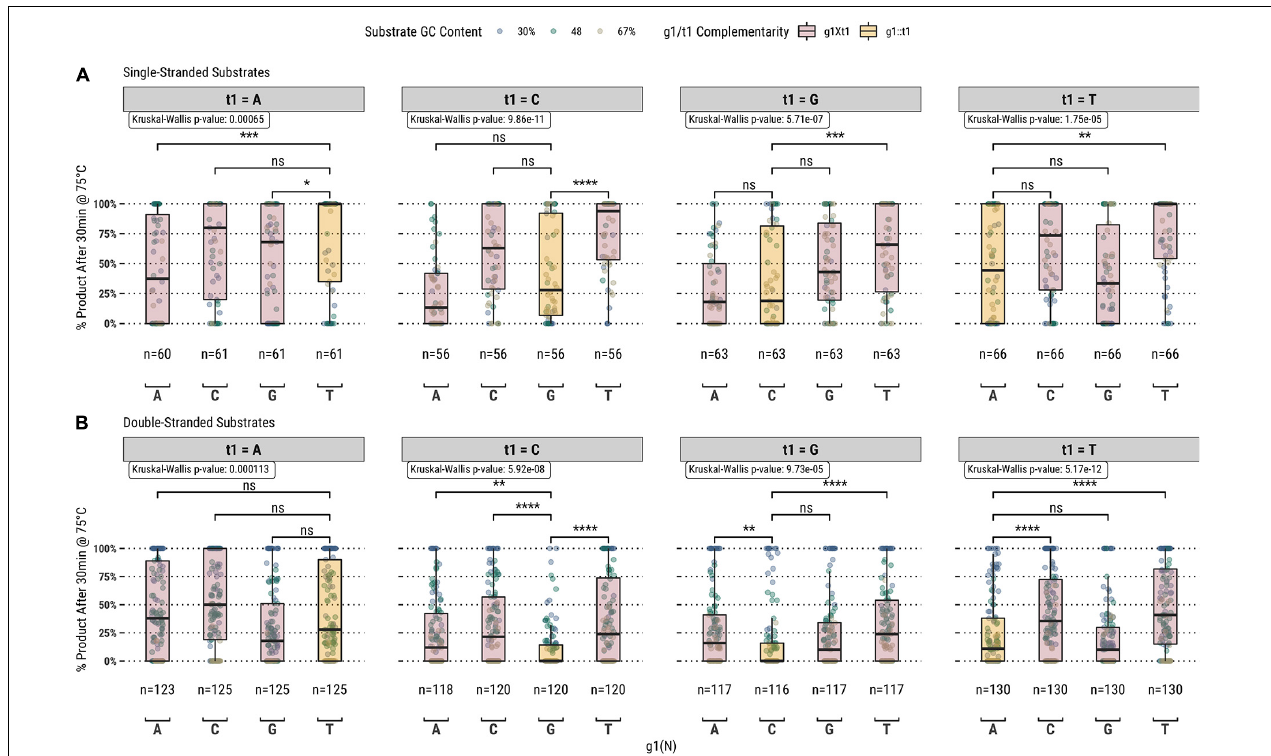
FIGURE 2 | Guided-endonuclease activity of TtAgo using fully-complementary guides, where g1 is complementary to t1 (g1:t1), and partially complementary guides, where g1 is not complementary to t1 (g1Xt1) acting on (A) single-stranded and (B) double-stranded DNA substrates. Significance levels shown only for g1:t1 to g1Xt1 comparisons. Boxplots have been annotated for statistical significance between relevant groups using the following labels: ns (not significant) for p > 0.05; ∗ for p ≤ 0.05, ∗∗ for p ≤ 0.01; ∗∗∗ for p ≤ 0.001; and ∗∗∗∗ for p ≤ 0.0001.